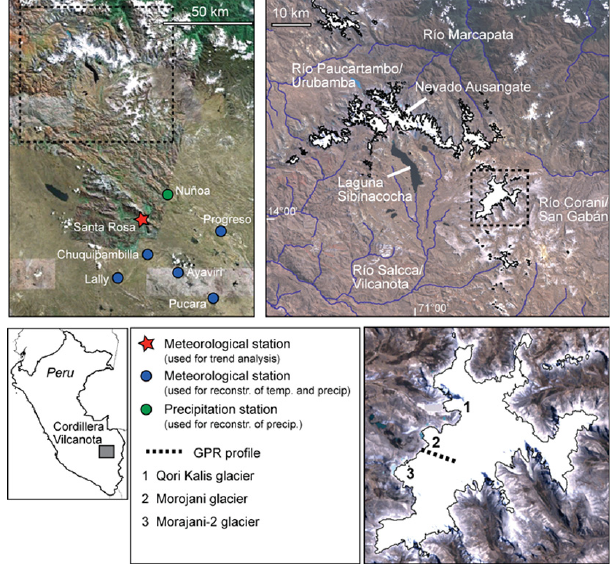
Fig. 1. Upper left: overview of study site; upper right: satellite view on the CV (Landsat-5TM, 4 August 2006) with major river catch- ments indicated. The glacier outlines of 2006 are marked with a black line. Lower right: a close-up of the QIC with the dashed line indicating the location of the GPR profile taken in 2008.